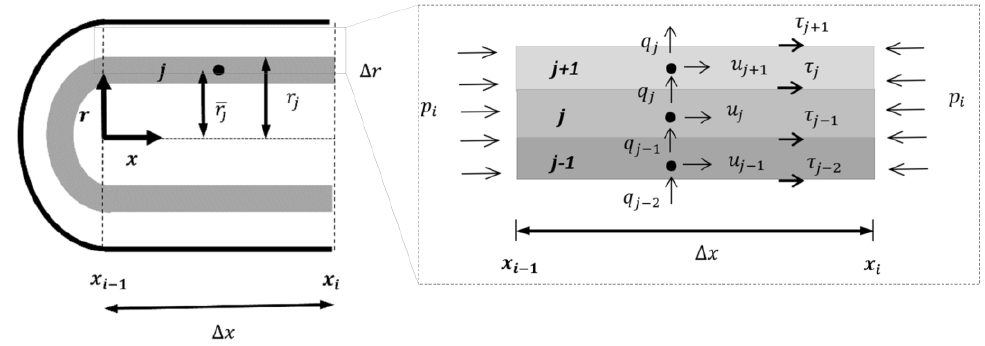
Figure 1. Radial grid system for numerical solution with Q2D model.